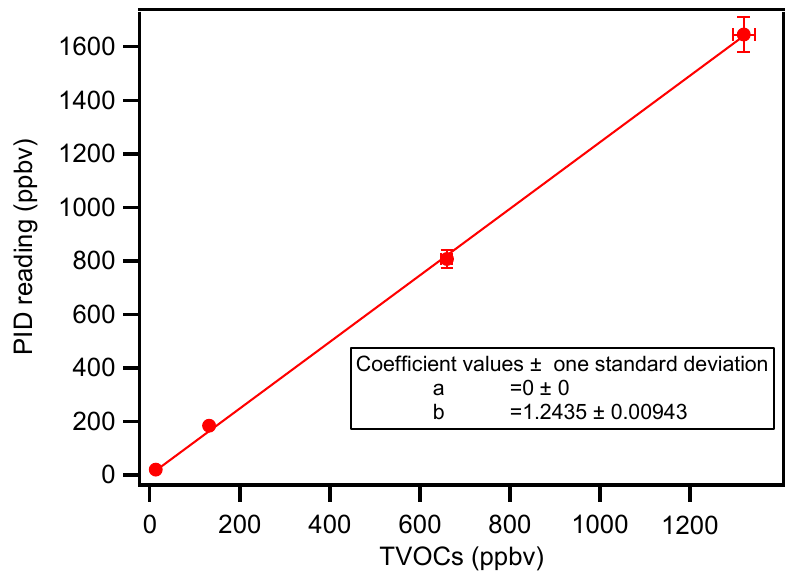
Figure 3. Linear relationship between the total mixing ratios of standard gases and PID-measured results.